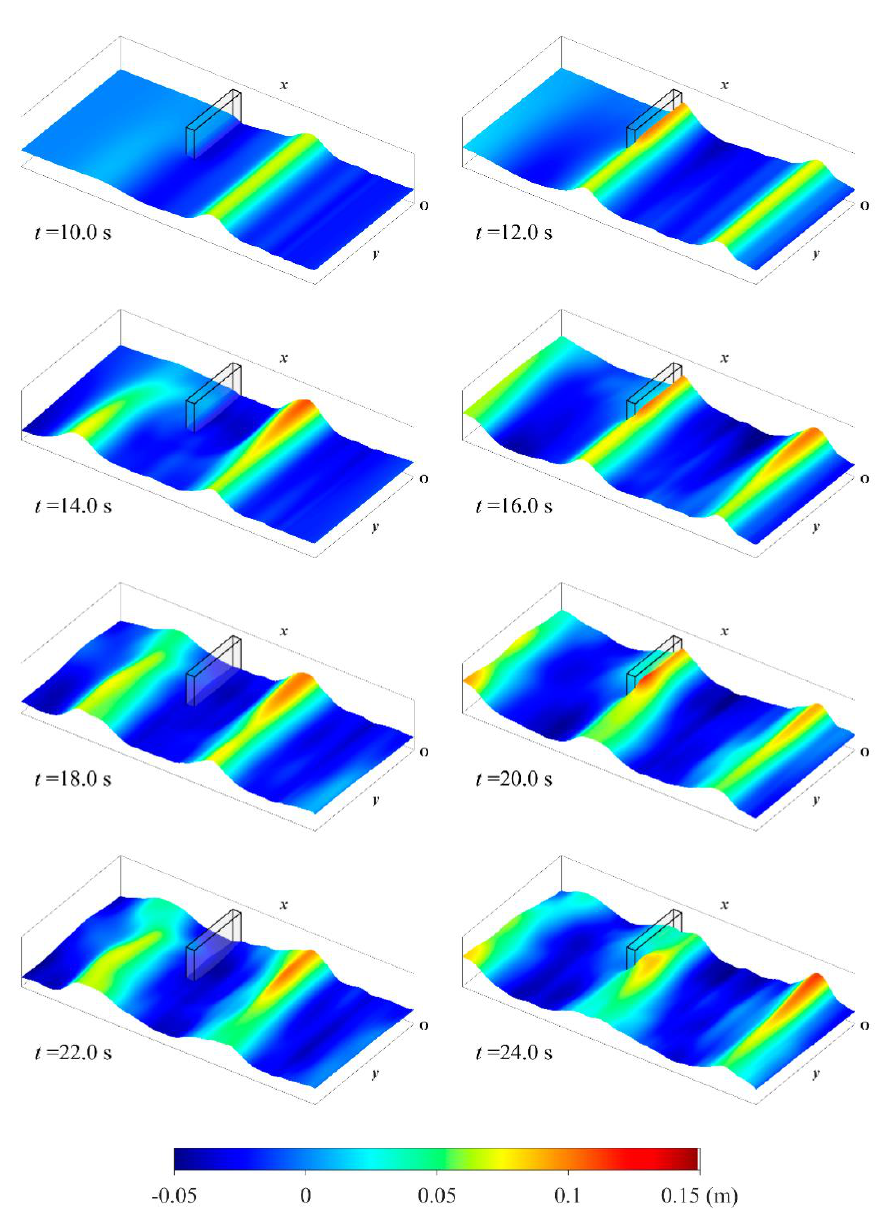
Figure 13. Free surface elevation at different instants for cnoidal wave interaction with a porous structure (wave propagates from right to left in each subfigure).